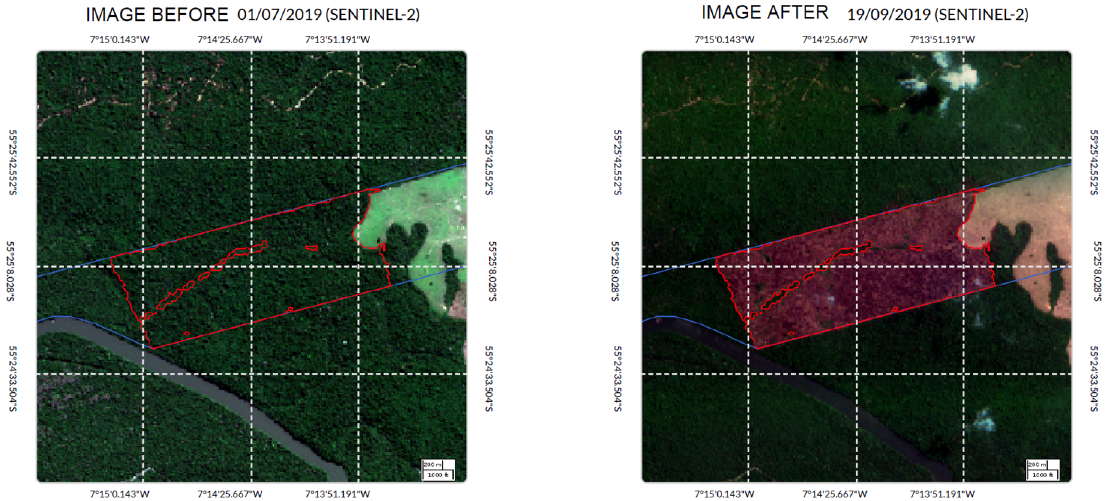
Figure 1. Example of a selected MapBiomas Alerta warning polygon selected for deforestation signal characterization. The id of the displayed polygon is 6561, and it is located in the Novo Progresso municipality, Pará state (Brazil).